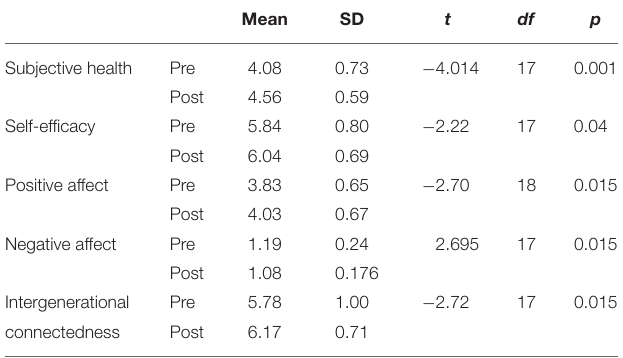
TABLE 1 | Quantitative t -test